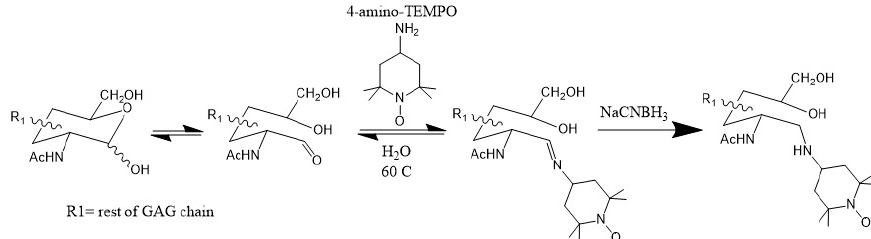
Figure 11. Reductive amination of the reducing end of glycans using 4-amino-TEMPO.